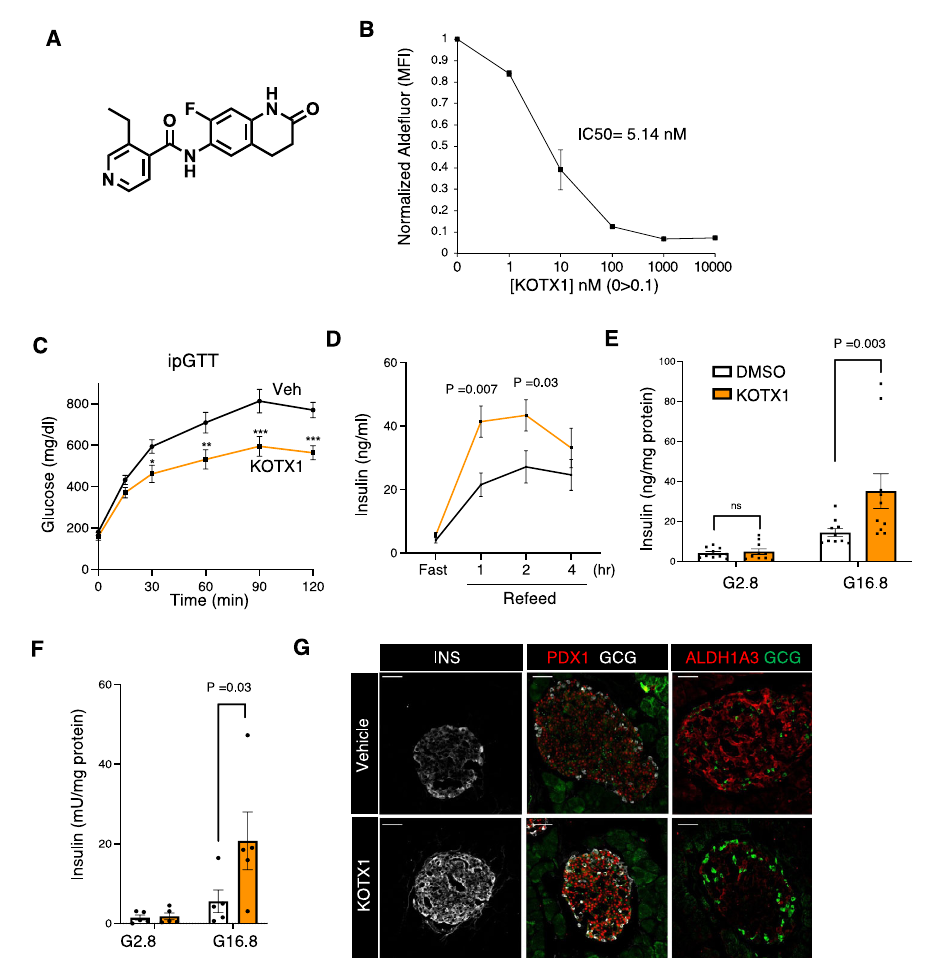
Fig.3|ALDH1A3inhibitorsimprove β -cellfunction.A KOTX1structure. B KOTX1 KOTX1( n =10pergroup). F InsulinsecretioninisletsfromT2Ddonorstreatedwith KOTX1asin( E )( n =5pergroup). G Immuno fl uorescenceforInsulin,ALDH1A3,and PDX1 in db/db mice treated with KOTX1. Representative immuno fl